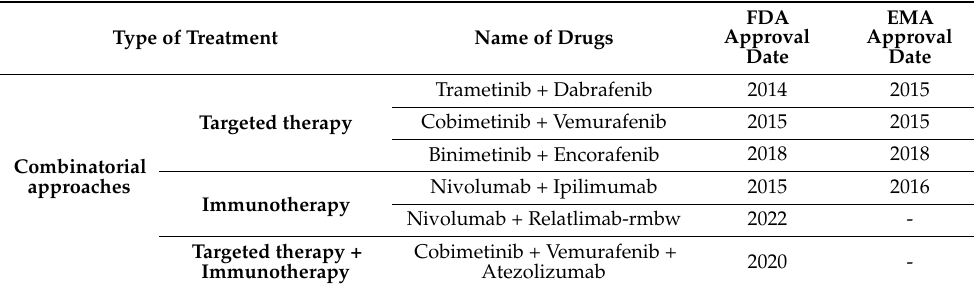
Table 3. Combination therapies for melanoma and years of approval by FDA and EMA.